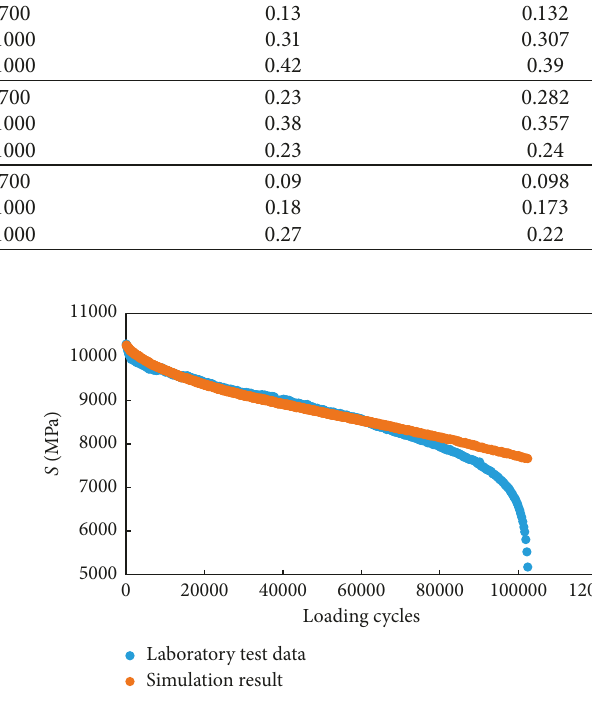
Figure 12: Comparison between simulated damage variable and measured damage variable of asphalt mixture.